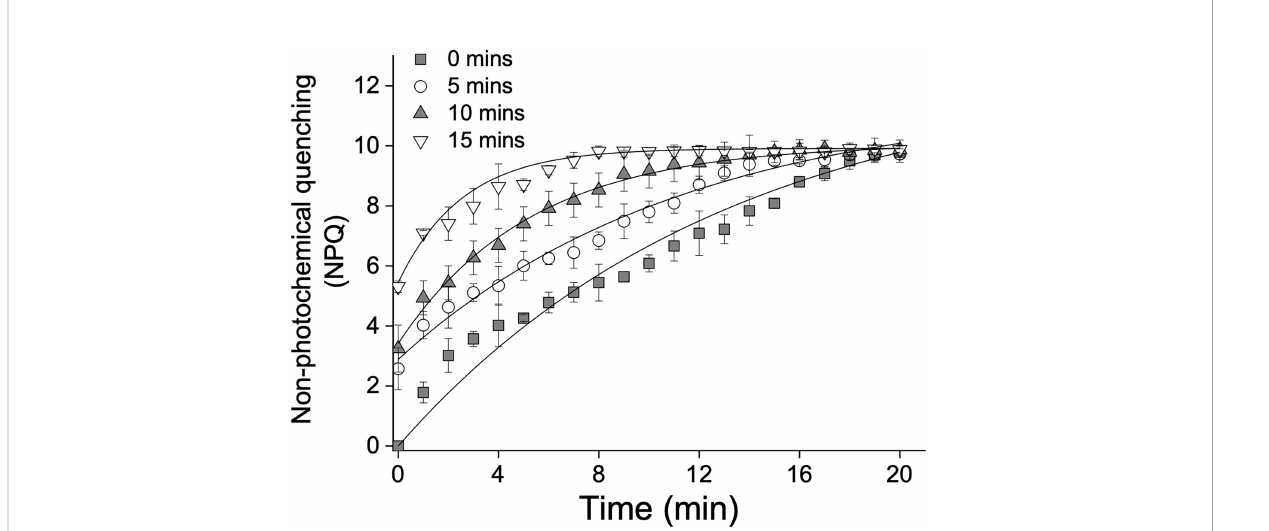
FIGURE 5 High light (1200 m mol photons m – 2 s – 1 )-induced non-photochemical quenching (NPQ) after 0 min (gray squares), 5 min (white circles), 10 min (gray tringles), and 15 min (white tringles) pre-illumination. Each curve represents the fi t (all p < 0.01 and all R 2 > 0.95) to the model of Ocampo- Alvarez and Garc ı ́ a-Mendoza (2013). Data represent the mean ± SD ( n =